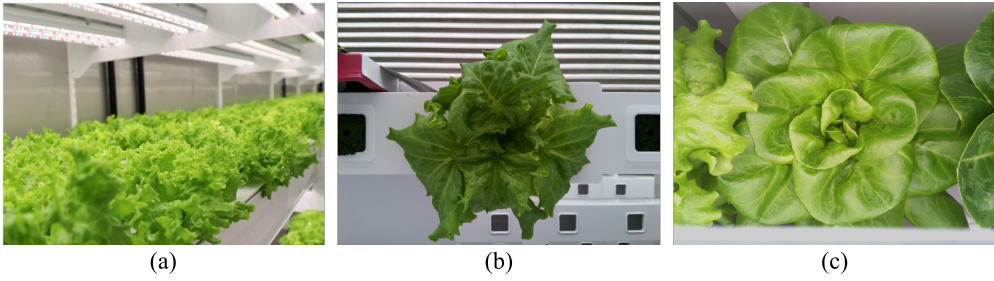
Figure 1. Examples of vertical farms environment: ( a ) a vertical farm cultivation environment; and ( b , c ) images of crop growth